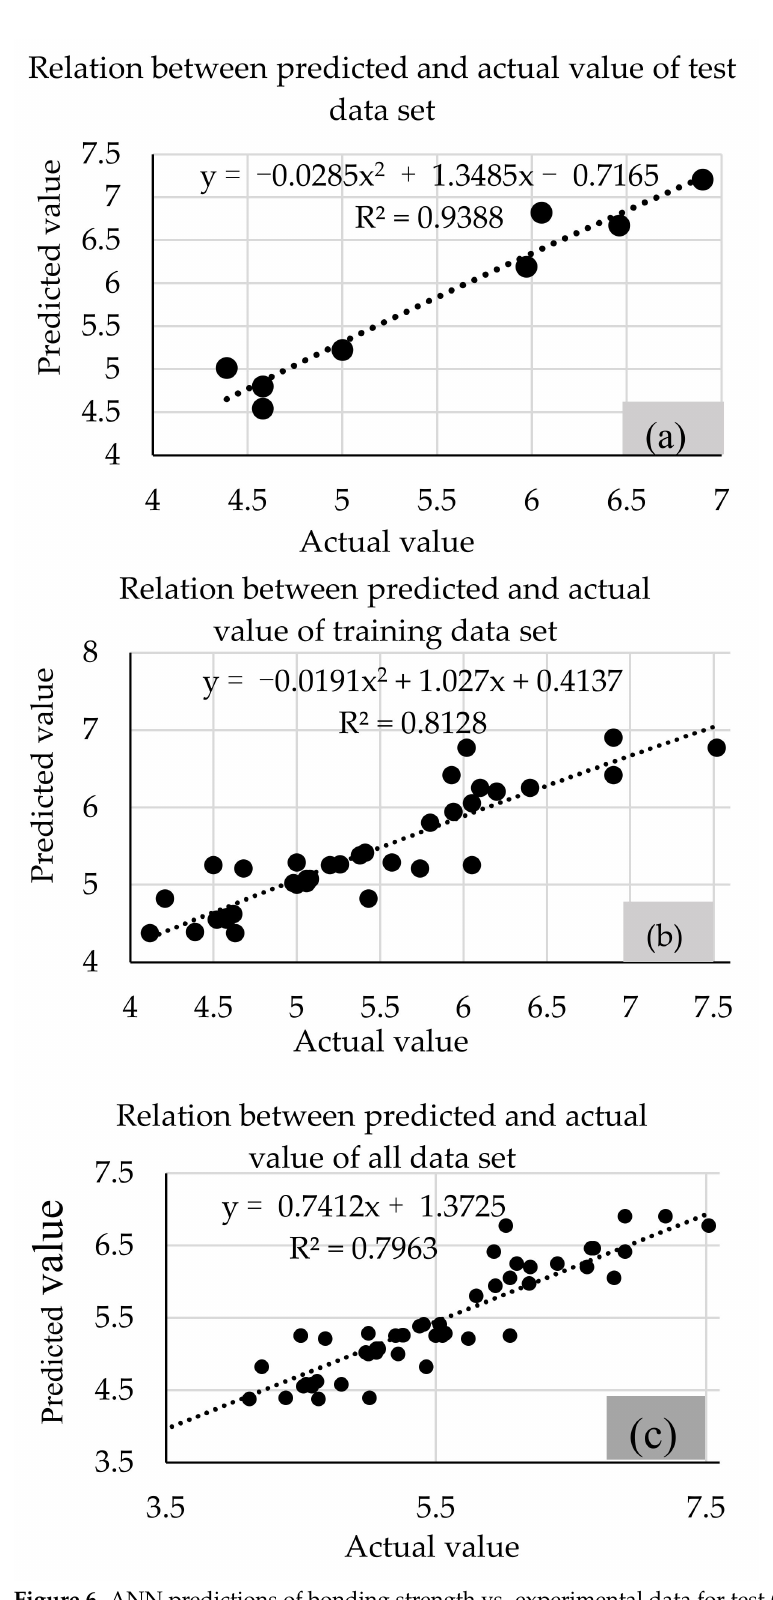
Figure 6. ANN predictions of bonding strength vs. experimental data for test ( a ), training ( b ), and all ( c ) data